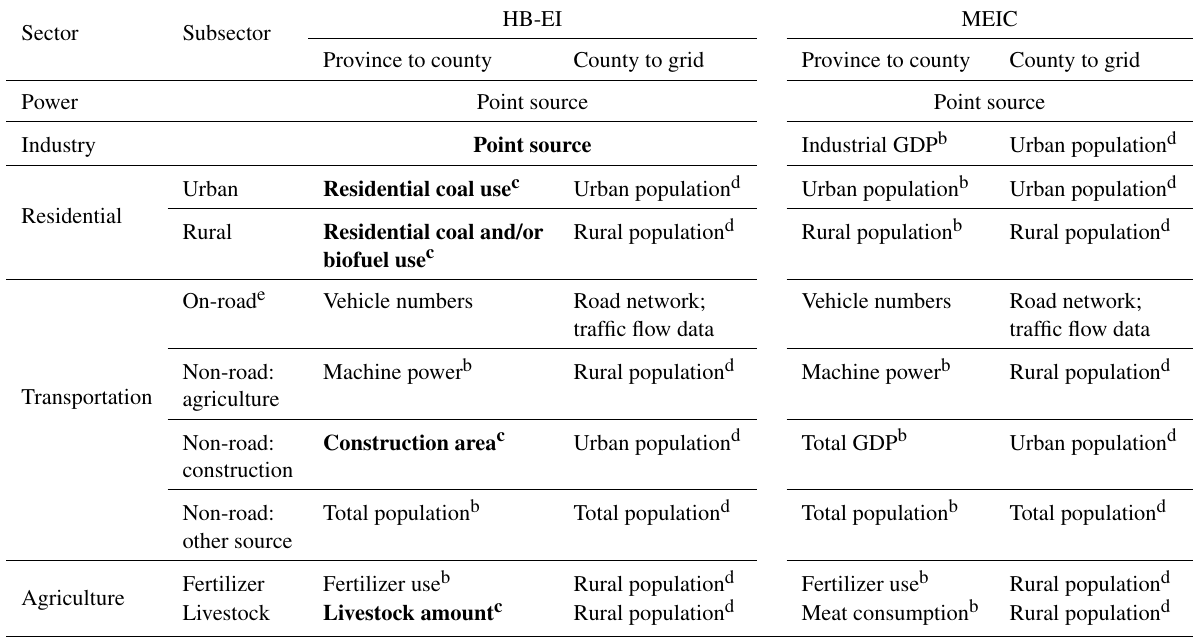
Table 1. Proxies used for spatial distributions of emissions in HB-EI and MEIC a